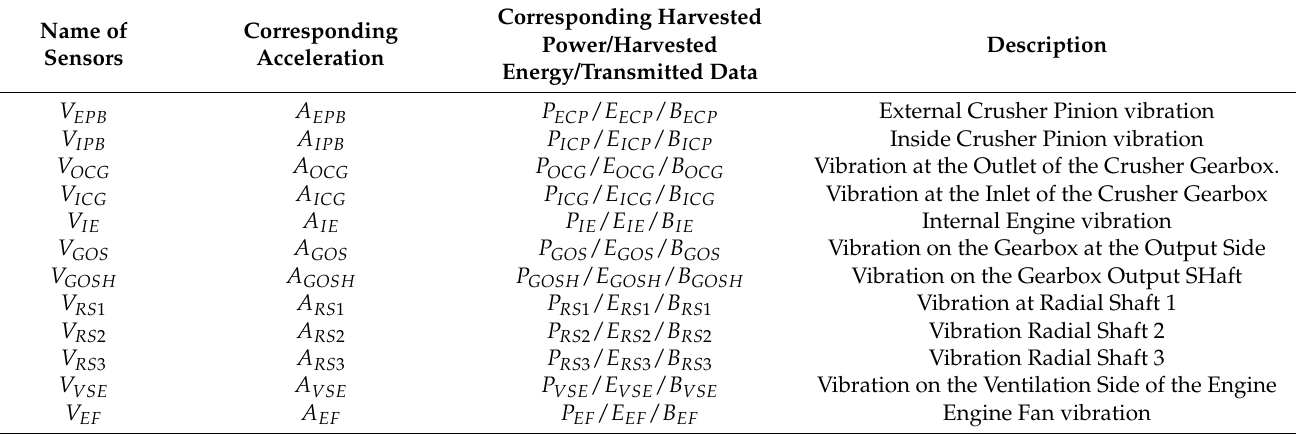
Table A1. Nomenclature of different sensors and